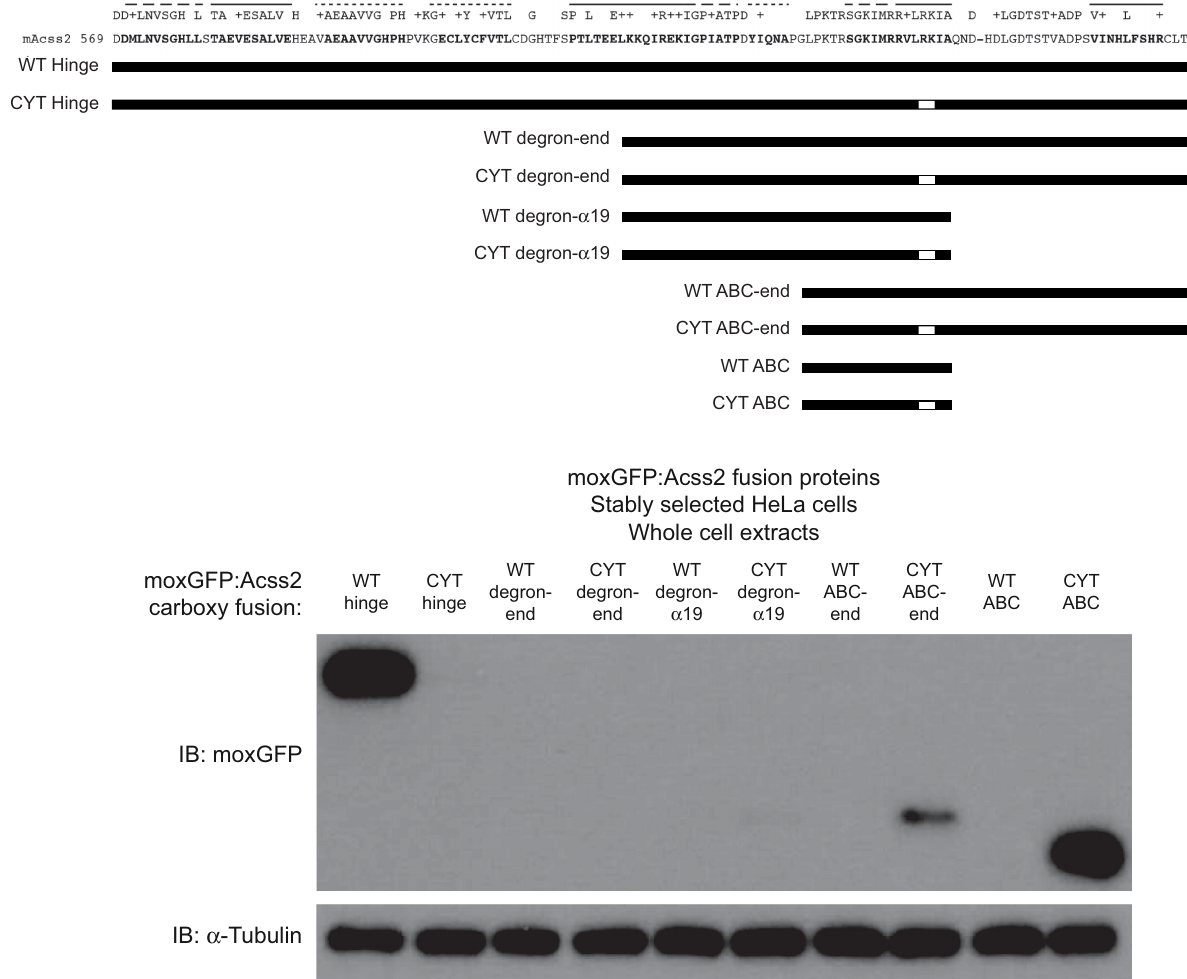
Fig 9. The Acss2 hinge region contains protein destabilization and masking elements. (A) Stable HeLa cell lines expressing select amino and carboxy terminal truncations as well as isolated sequences of the WT or ED Acss2 carboxy terminal hinge region fused to the carboxy terminus of the green fluorescent protein moxGFP were generated by lentiviral transduction followed by drug selection. (B) Immunoblots for the moxGFP:Acss2 fusion proteins were performed to assess relative protein levels (normalized to protein amount and compared to immunoblot of α -tubulin).